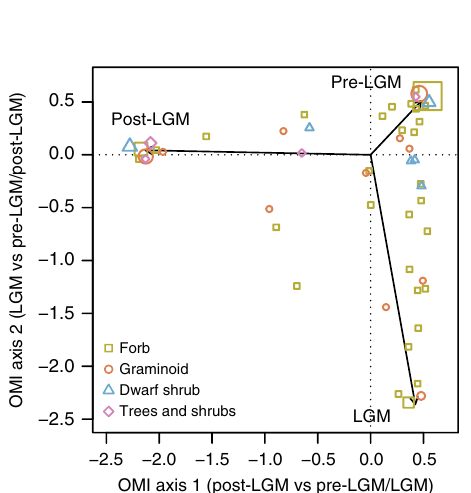
Fig. 2 Positioning of northern high-latitude plants in historical climatic niche space. The OMI constrained ordination approach is used to estimate the niche position of plant species (points) as de fi ned by their abundance in three climatically different periods during the late Quaternary: pre-LGM, LGM and post-LGM. Symbol sizes are scaled to represent the density of data points at identical positions in ordination